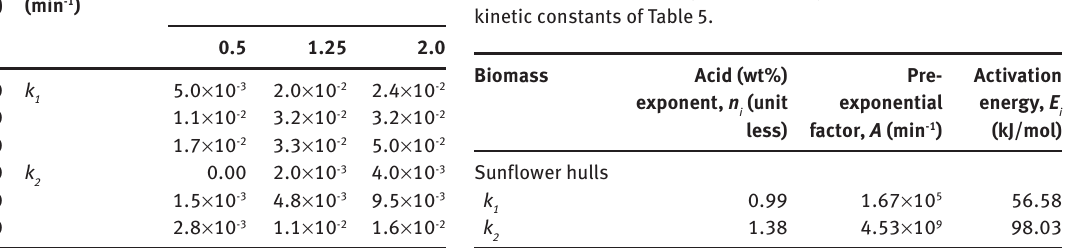
Table 5 Best-fitted rate constants of Eqs. (2)–(5). Reaction